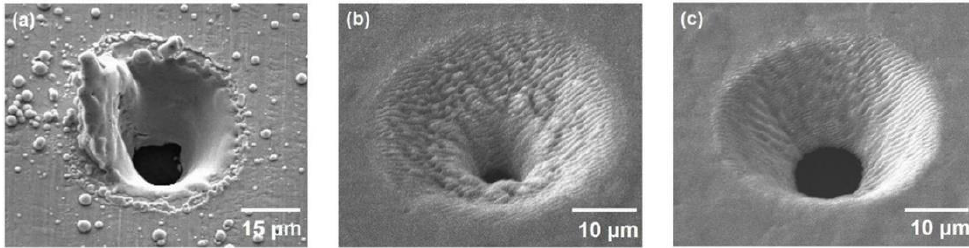
Figure 6. Ref. [70] SEM images of micro-holes on Invar were processed at three pulse durations of ( a ) 10 ns, ( b ) 15 ps, and ( c ) 300 fs, respectively. The ns laser parameters are F = 5 J/cm 2 , f = 50 Hz, and λ = 248 nm . For the ps and fs laser, F = 0.29 J/cm 2 , f = 200 kHz, and λ = 1035 nm.